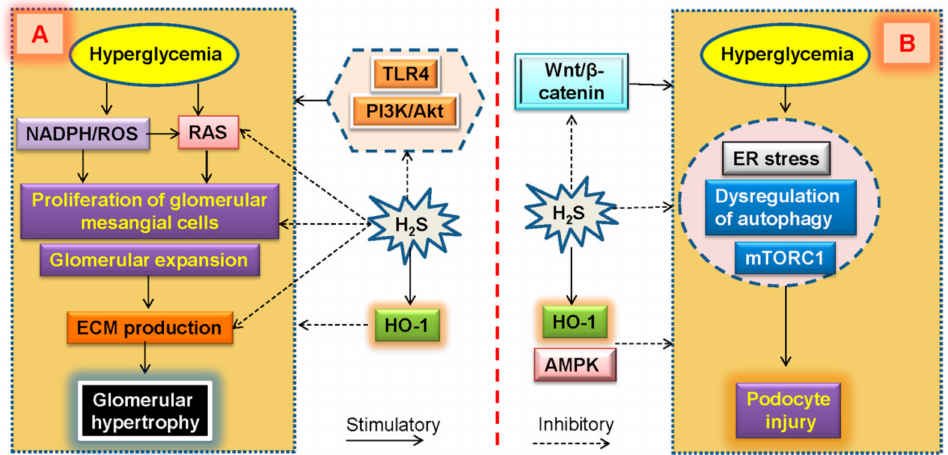
Figure 7. E ff ect of H 2 S on glomerular hypertrophy and podocyte injury in diabetic kidneys. ( A ) Activation of intrarenal renin-angiotensin system and NADPH-derived ROS contribute to the proliferation and ECM secretion in high glucose-incubated renal mesangial cells, this phenomenon is attenuated by H 2 S, dependent on HO-1 induction and inhibition of TLR4 and PI3K / Akt pathway. ( B ) Further studies reveal that endoplasmic reticulum stress, dysregulation of autophagy and mTORC1 activation in podocyte promote the development of diabetic nephropathy. H 2 S may induce AMPK phosphorylation and HO-1, and suppress the Wnt / β -catenin pathway to mitigate podocyte injury induced by hyperglycemia. NADPH, reduced nicotinamide adenine dinucleotide phosphate; ROS, reactive oxygen species; ECM, extracellular matrix; HO-1, heme oxygenase-1; TLR4, toll-like receptor 4; mTORC1, mammalian target of rapamycin (mTOR) complex 1; AMPK, adenosine 5’-monophosphate (AMP)-activated protein